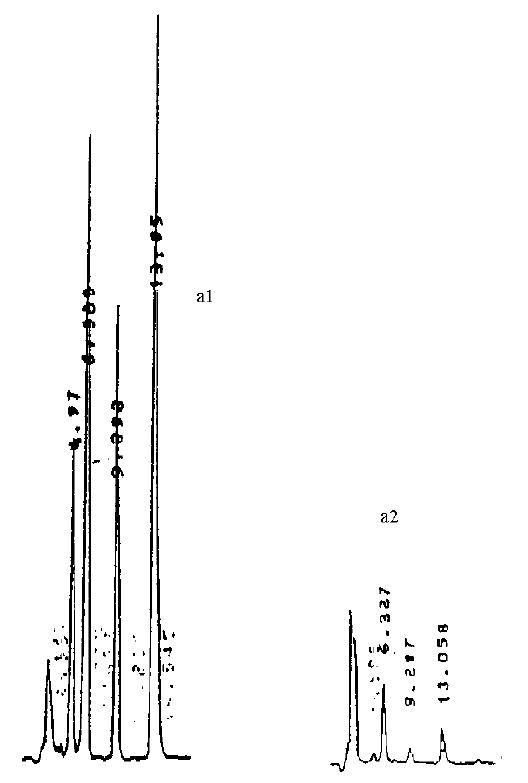
Figure 1. HPLC analysis of Aflatoxins in egg extracted using both